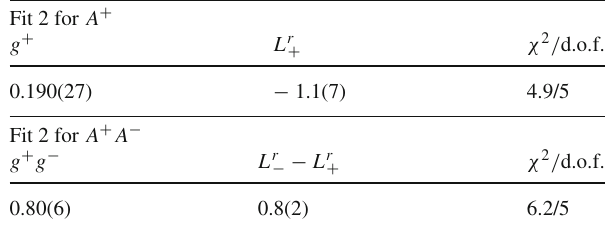
expansion of the couplings as in Eqs. (25,26,29). In Fit 2, we